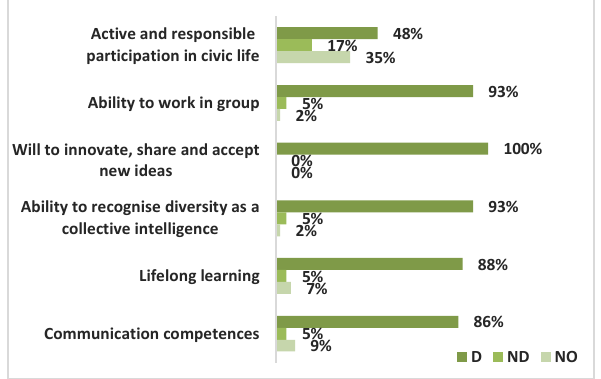
Figure 1. Percentage of responses regarding the social, technological and professional areas.